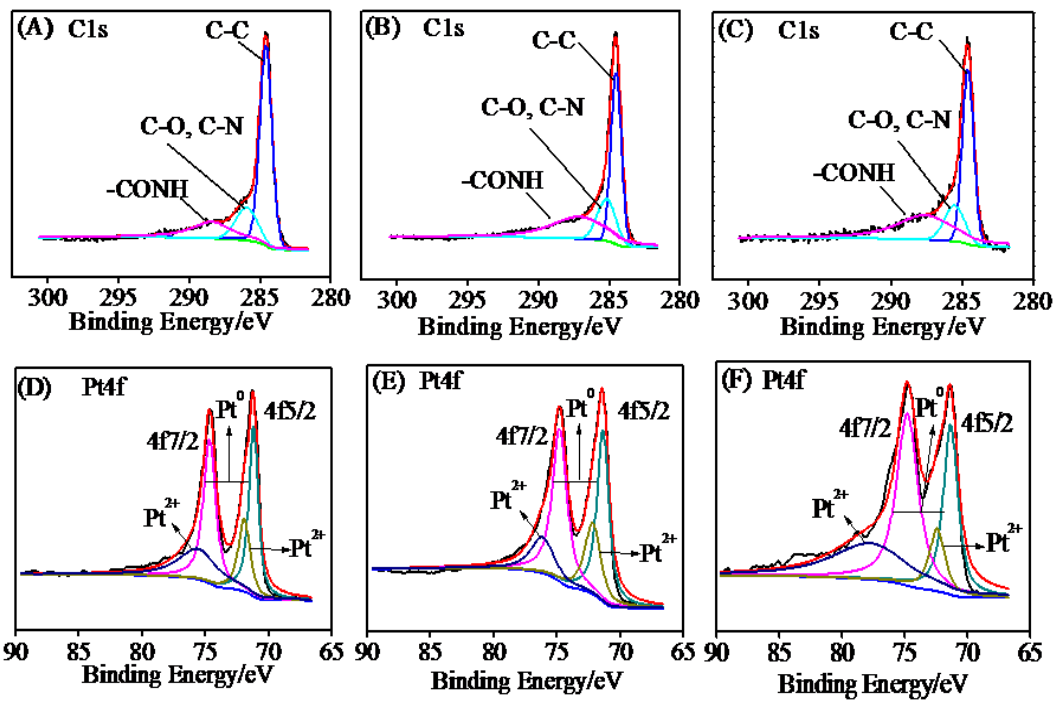
Figure 1. C1s XPS spectra of Pt/GNs ( A ); Pt/GNs (CS) ( B ); Pt/GNs (PAMAM ‐ polyamidoamine) ( C ); Pt 4f XPS spectra of Pt/GNs ( D ); Pt/GNs (CS) ( E ); Pt/GNs (PAMAM) ( F ).